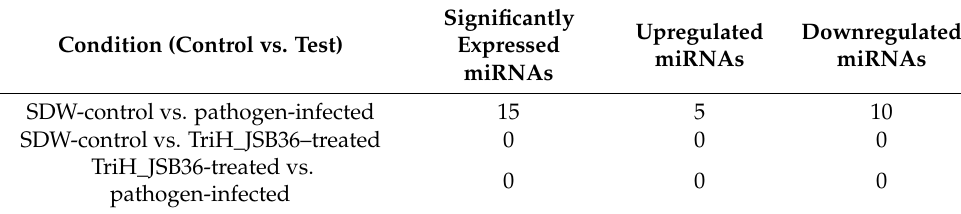
Table 3. Number of differentially expressed (i.e., upregulated and downregulated) miRNAs obtained from SDW-control vs. pathogen-infected, SDW-control vs. TriH_JSB36-treated, and TriH_JSB36- treated vs. pathogen-infected (Test)